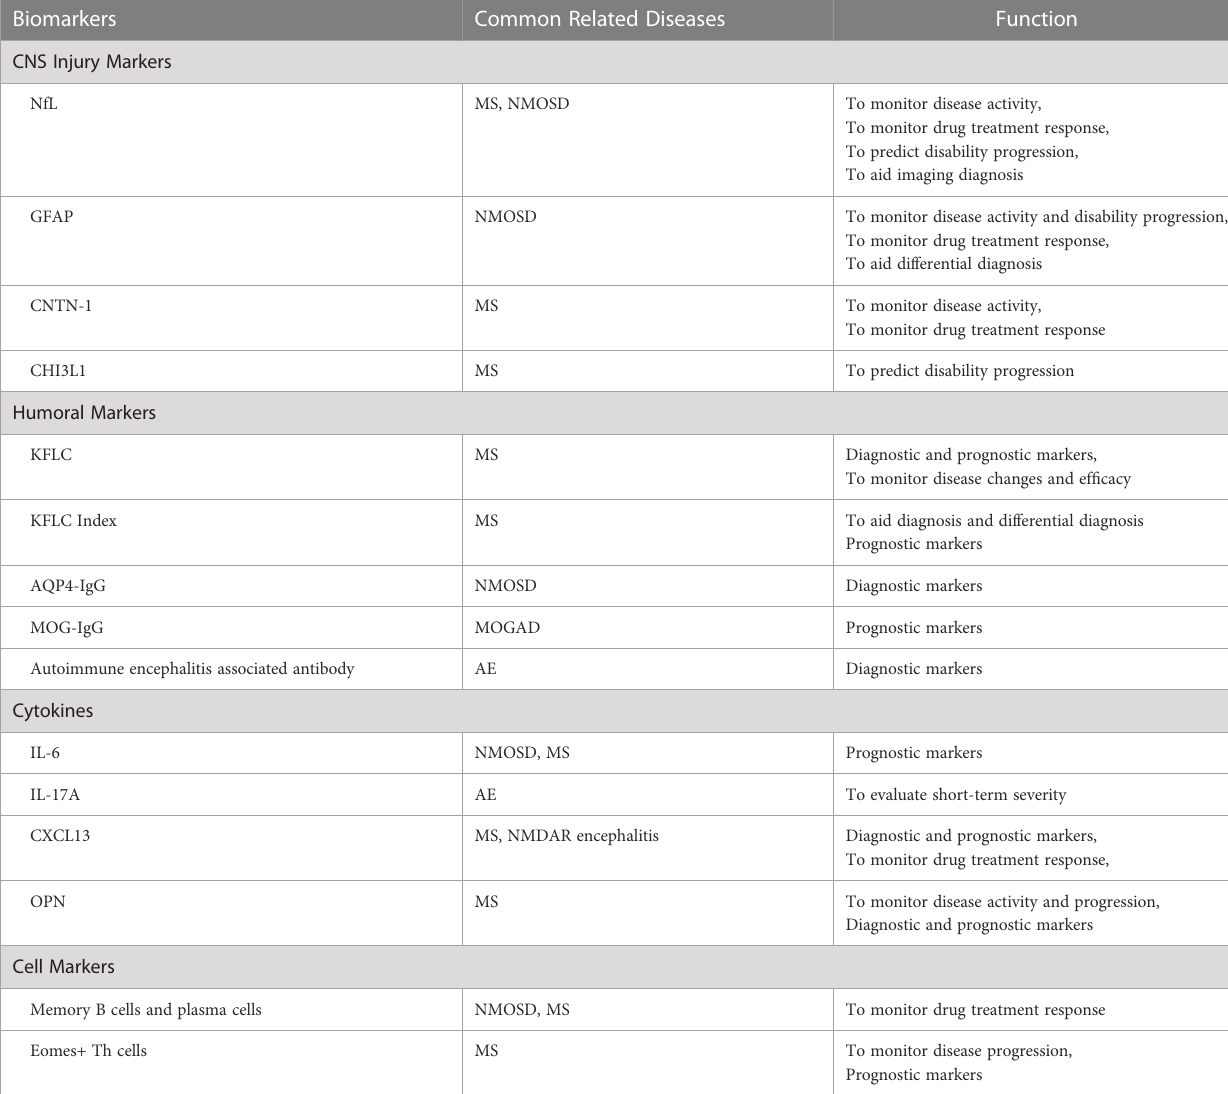
TABLE 1 Overview of the biomarkers described in this